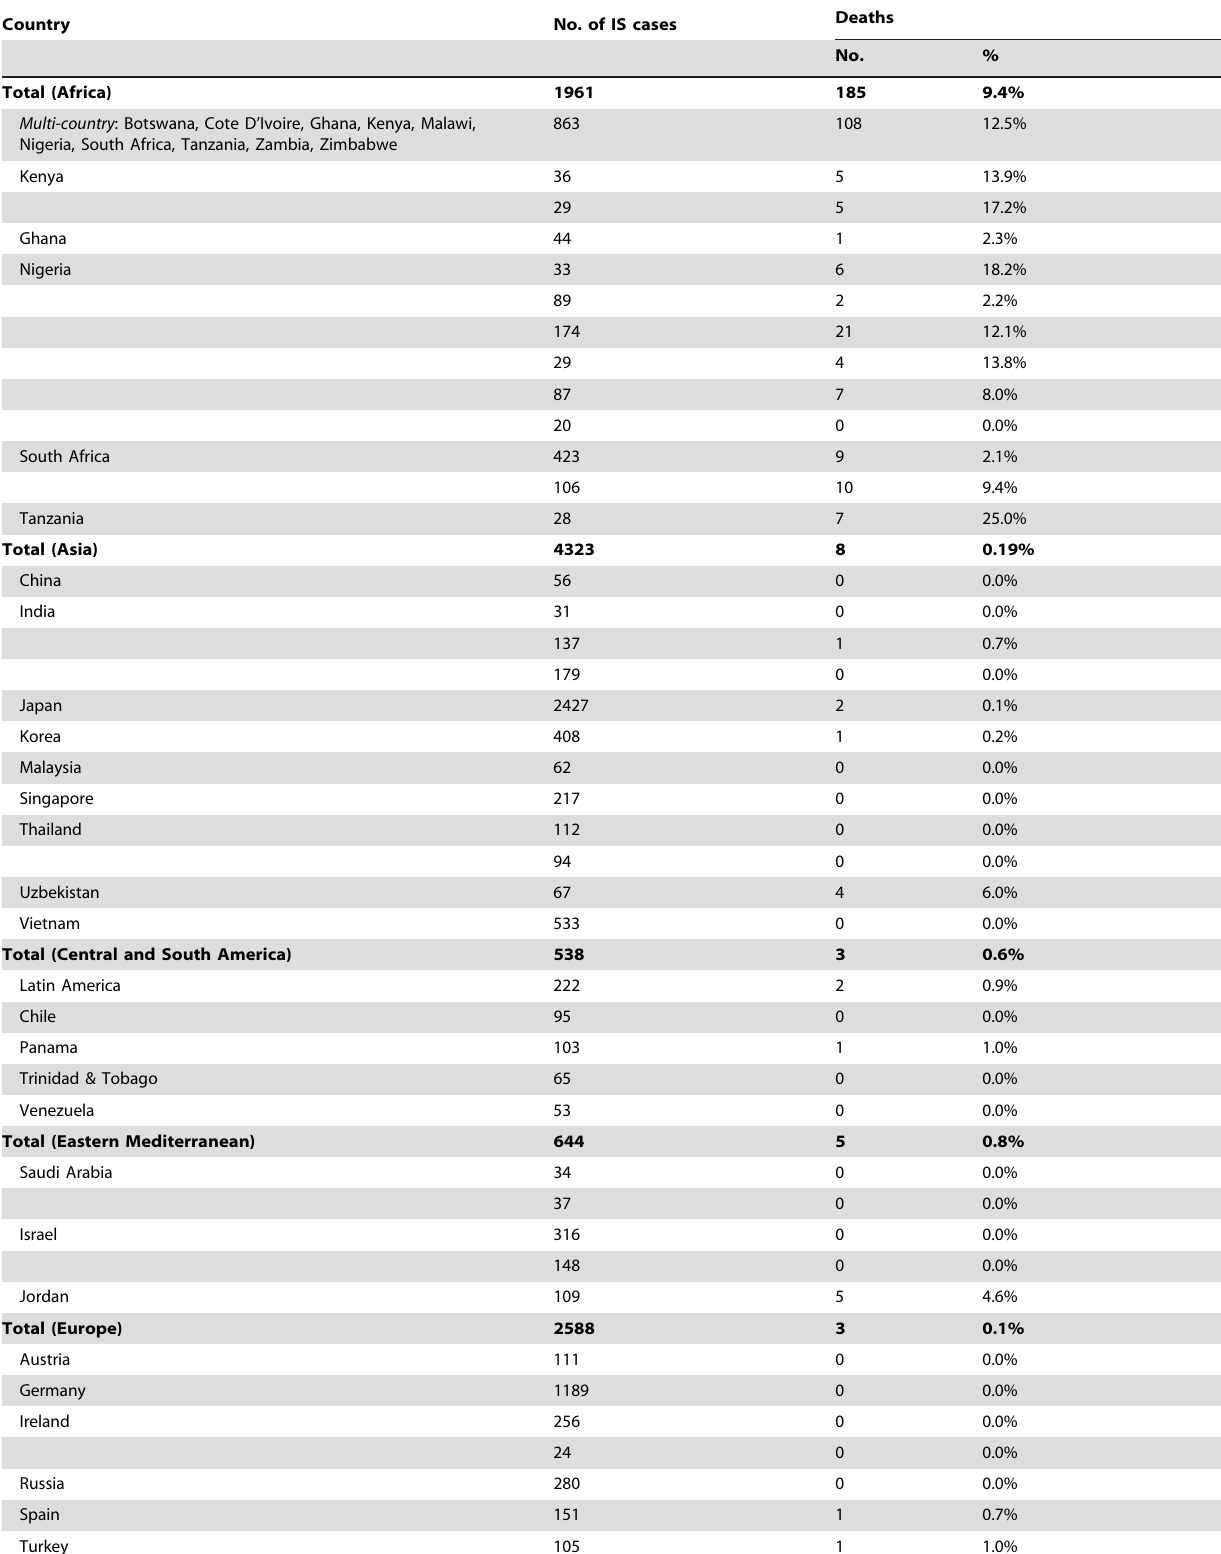
Table 3. Case-fatality among children hospitalized with intussusception.